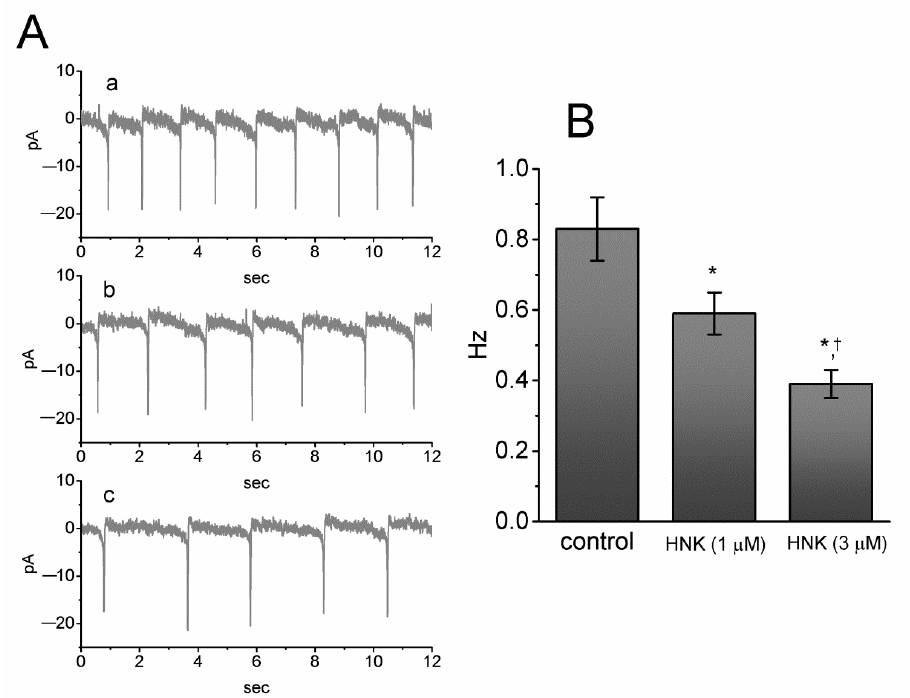
Figure 6. Effect of HNK on spontaneous action currents (ACs) in GH 3 cells. In this set of experiments, we performed cell-attached current recordings in cells bathed in normal Tyrode’s solution containing 1.8 mM CaCl 2 and the potential was held at the resting potential of the cells (around −70 mV). ( A ) Representative ACs taken from the absence or presence of HNK. Current trace labeled a is control, and that labeled b or c was obtained 2 min after addition of 1 μM HNK or 3 μM HNK, respectively. The downward deflections represent the capacitive currents that charge the surface membrane. ( B ) Summary bar graph depicting effect of HNK on the firing frequency of spontaneous ACs. Each bar indicates the mean ± SEM ( n = 8). * Significantly different from control ( p < 0.05) and † significantly different from HNK (1 μM) alone group ( p < 0.05).